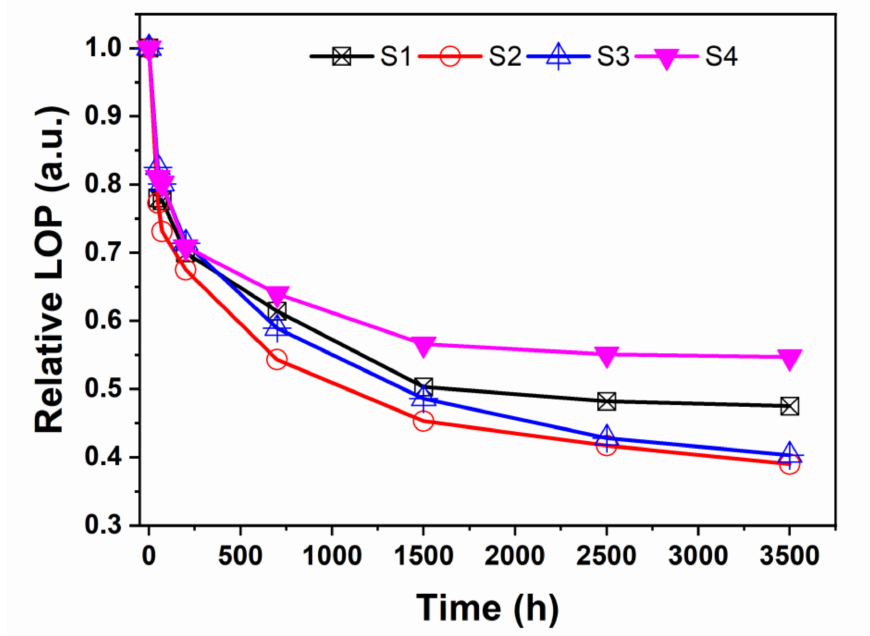
Figure 3. Relative LOPs measured at 100 mA during aging tests of samples